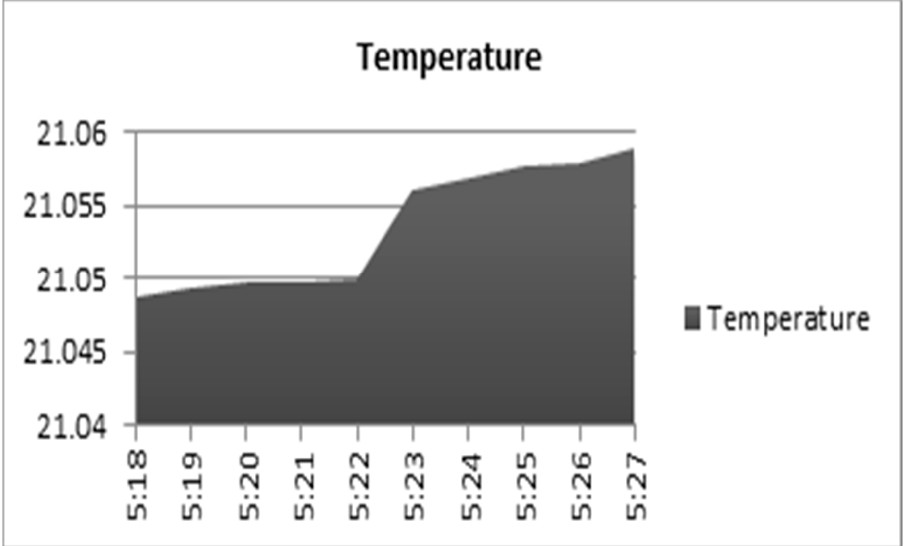
Figure 11. Room temperature level over